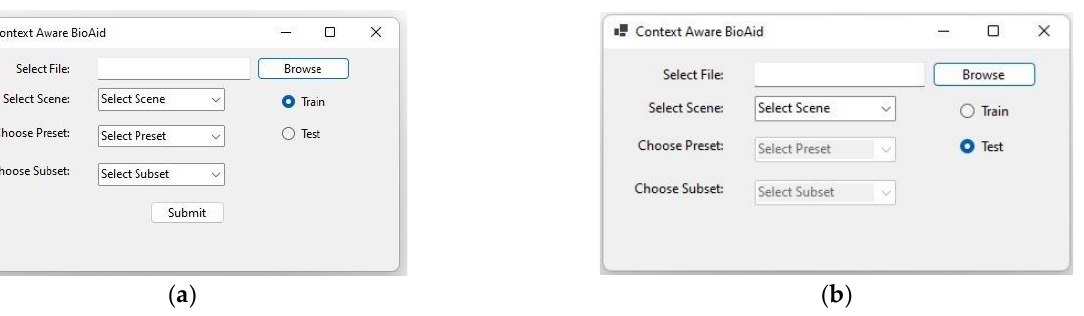
Figure 4. GUI of context aware BioAid system ( a ) training phase ( b ) testing phase.